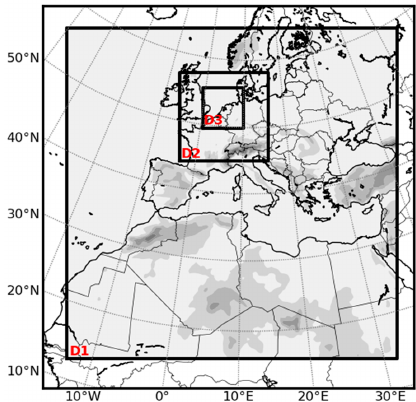
Figure 1. The three nested domains used to run WRF ‐ CHIMERE. D1 is 36 km resolution, D2 12 km, and D3 4 km (cloud resolving).